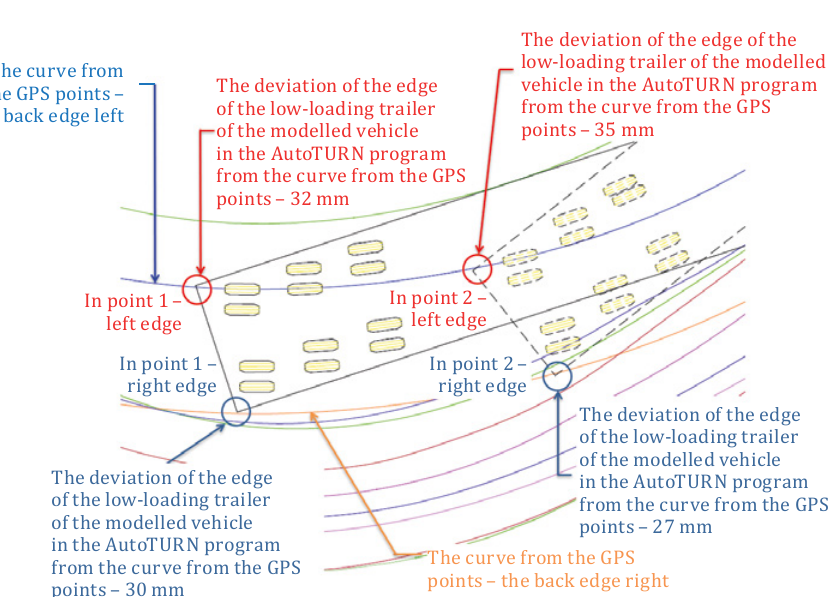
Figure 5. Curves from points and verification of deviations